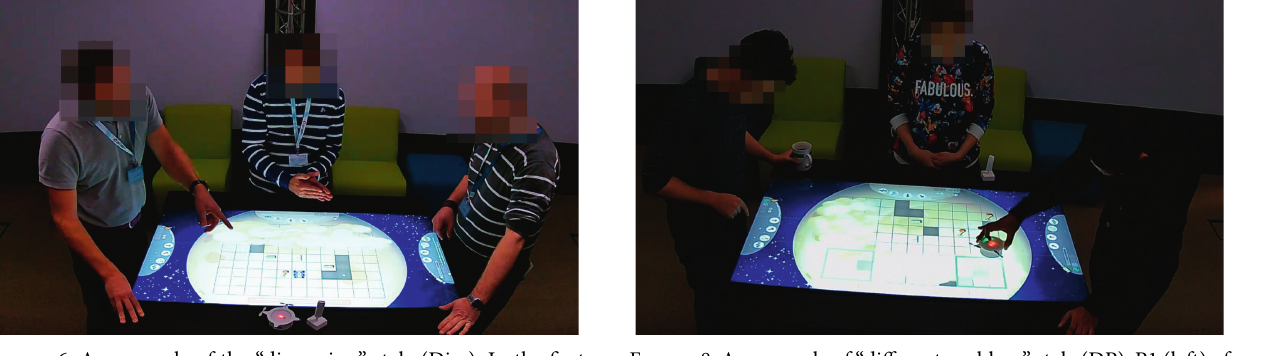
Figure 6: An example of the “discussion” style (Disc): In the first mission, G1 actively discuss the elements of the grid and the possible strategies. They use gestures to support their statements.